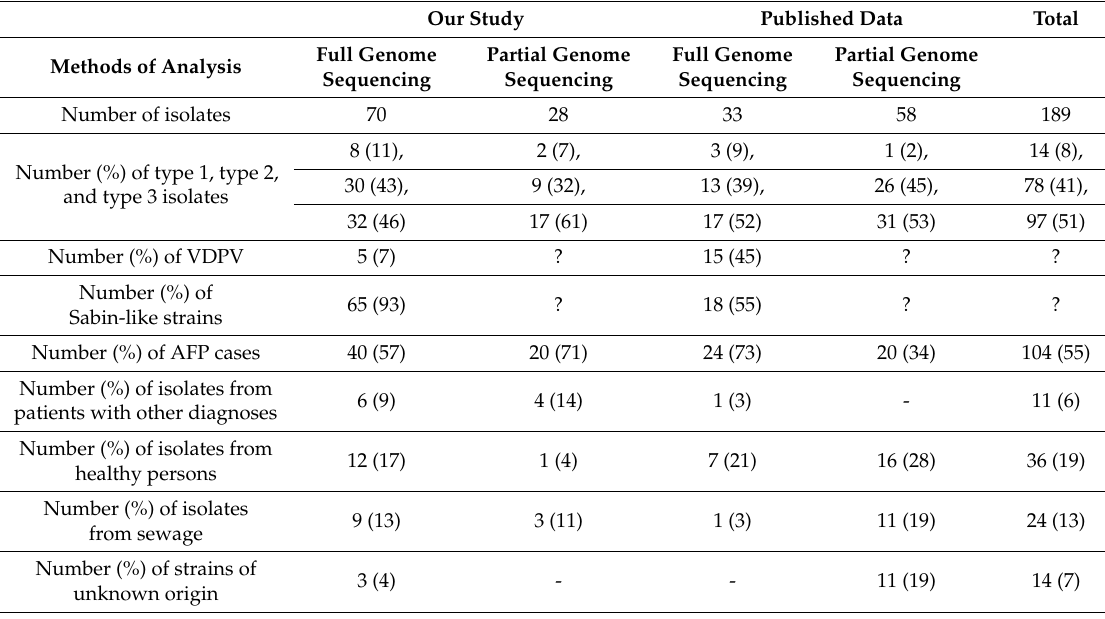
Table 1. Overview of the set of analyzed intertypic